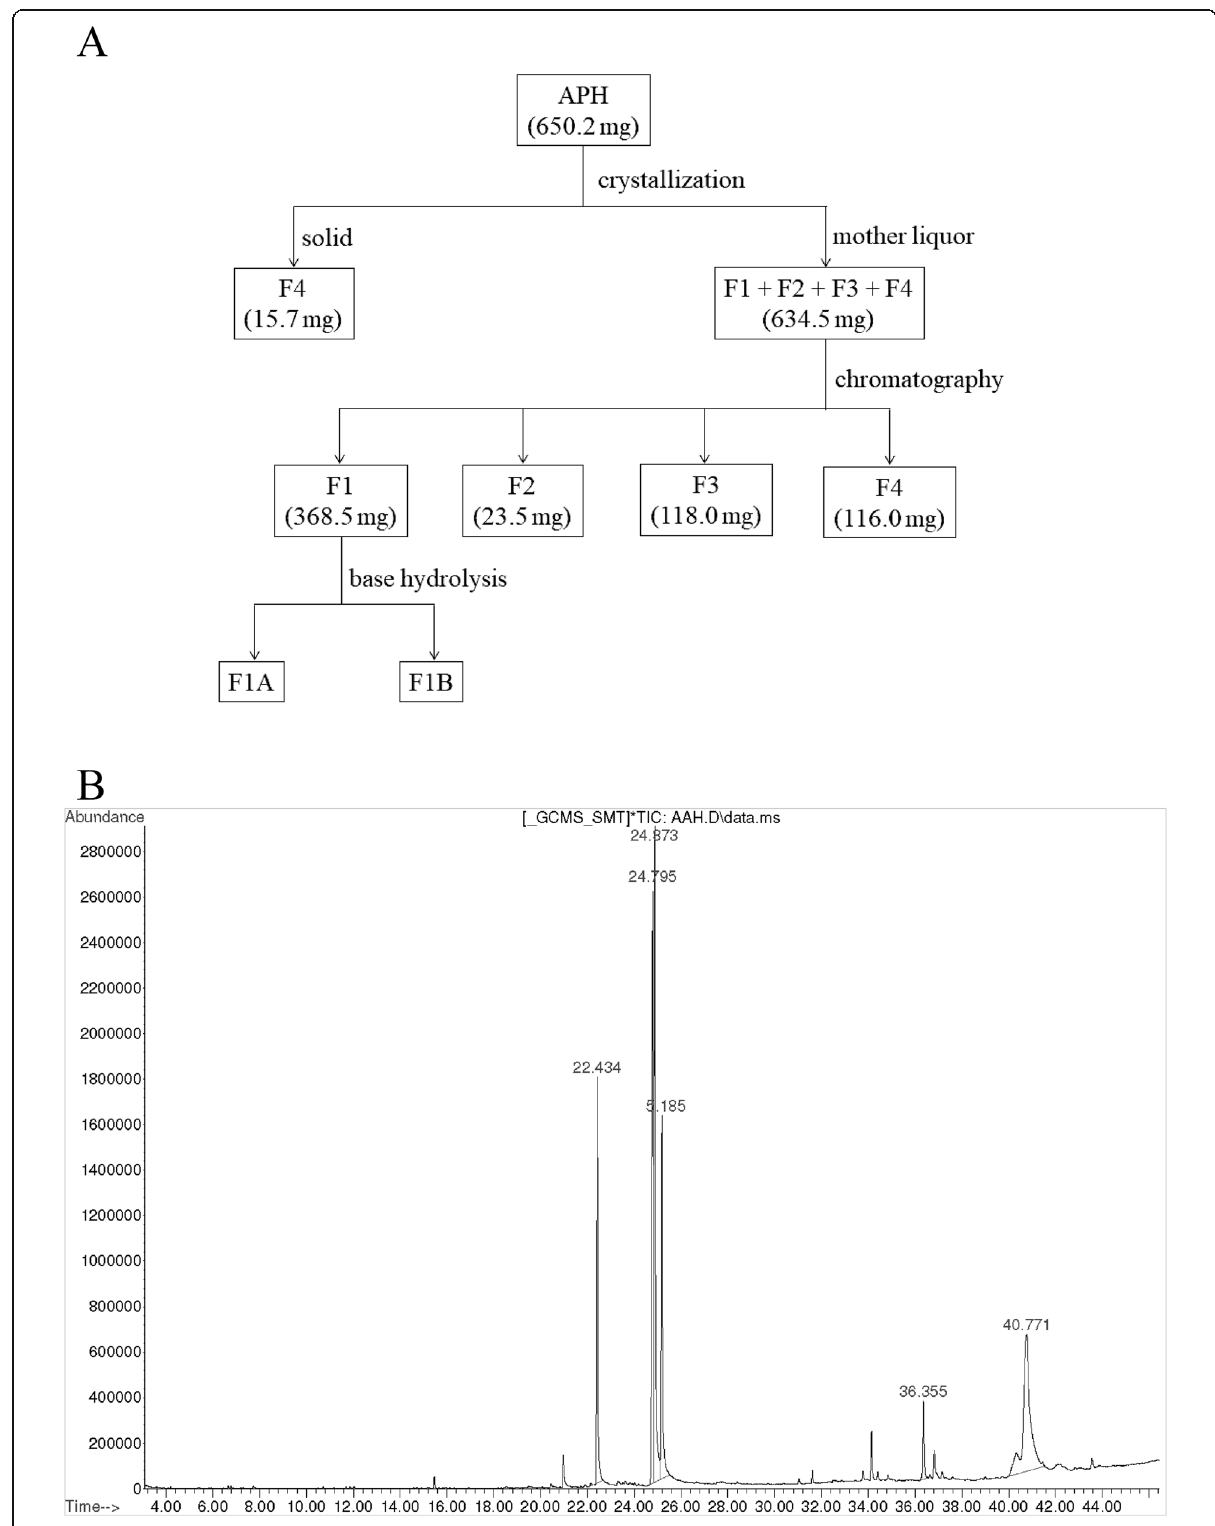
Fig. 3 APH isolation and identification. a Schematic representation of APH isolation. b Gas chromatogram of